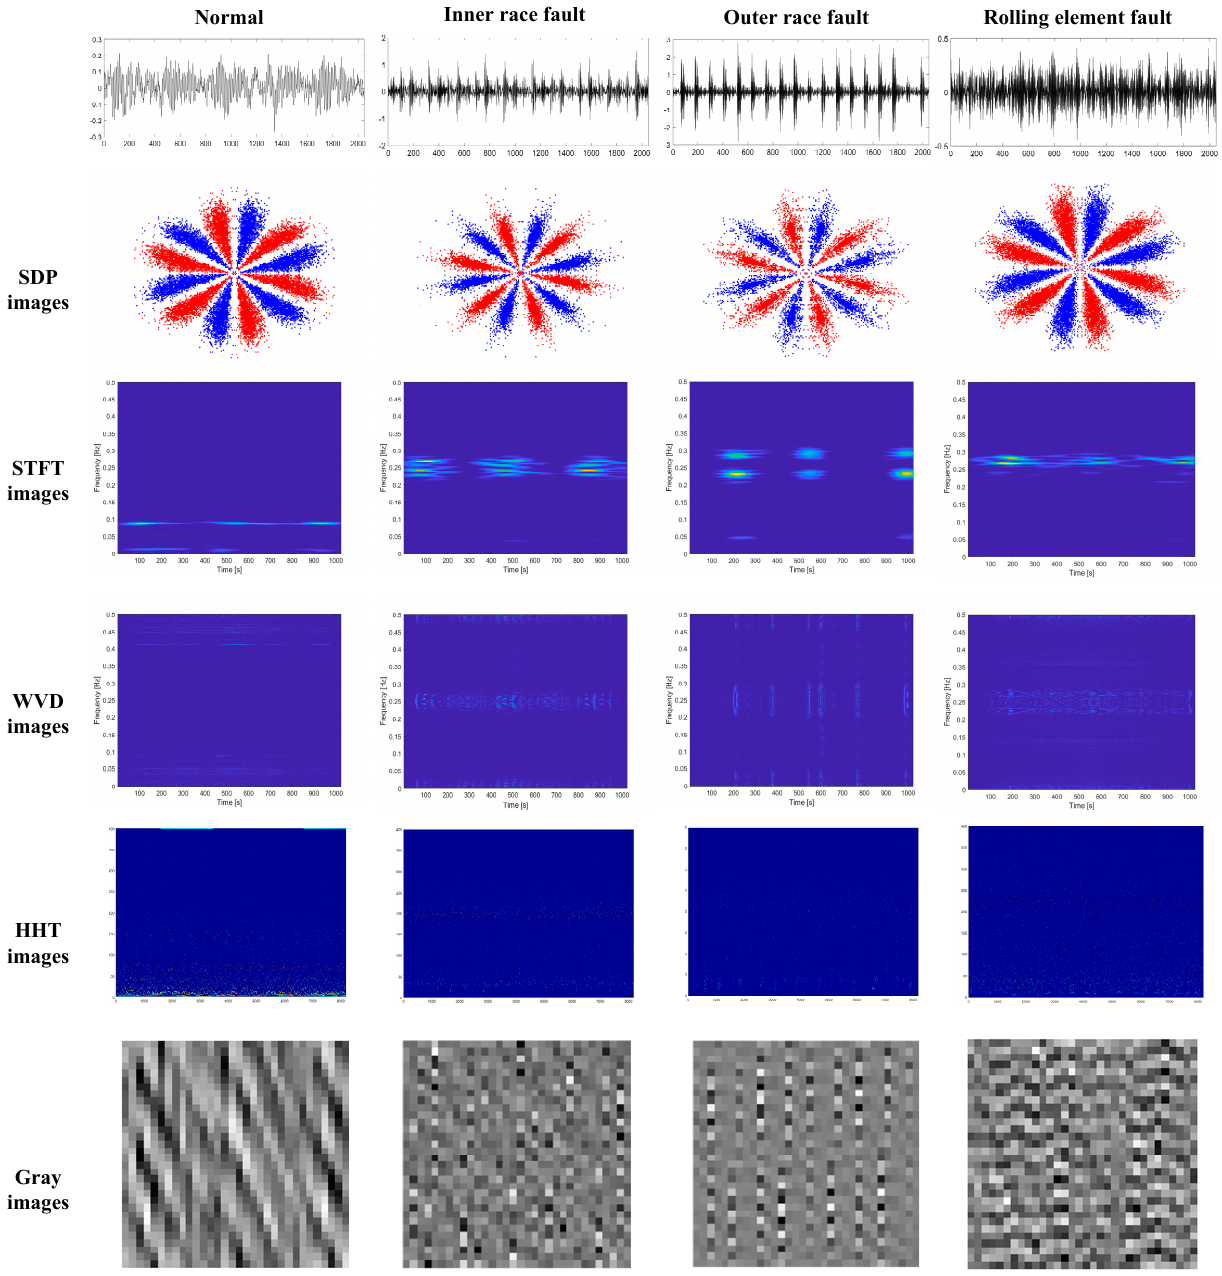
Figure 9. Five types of input images.